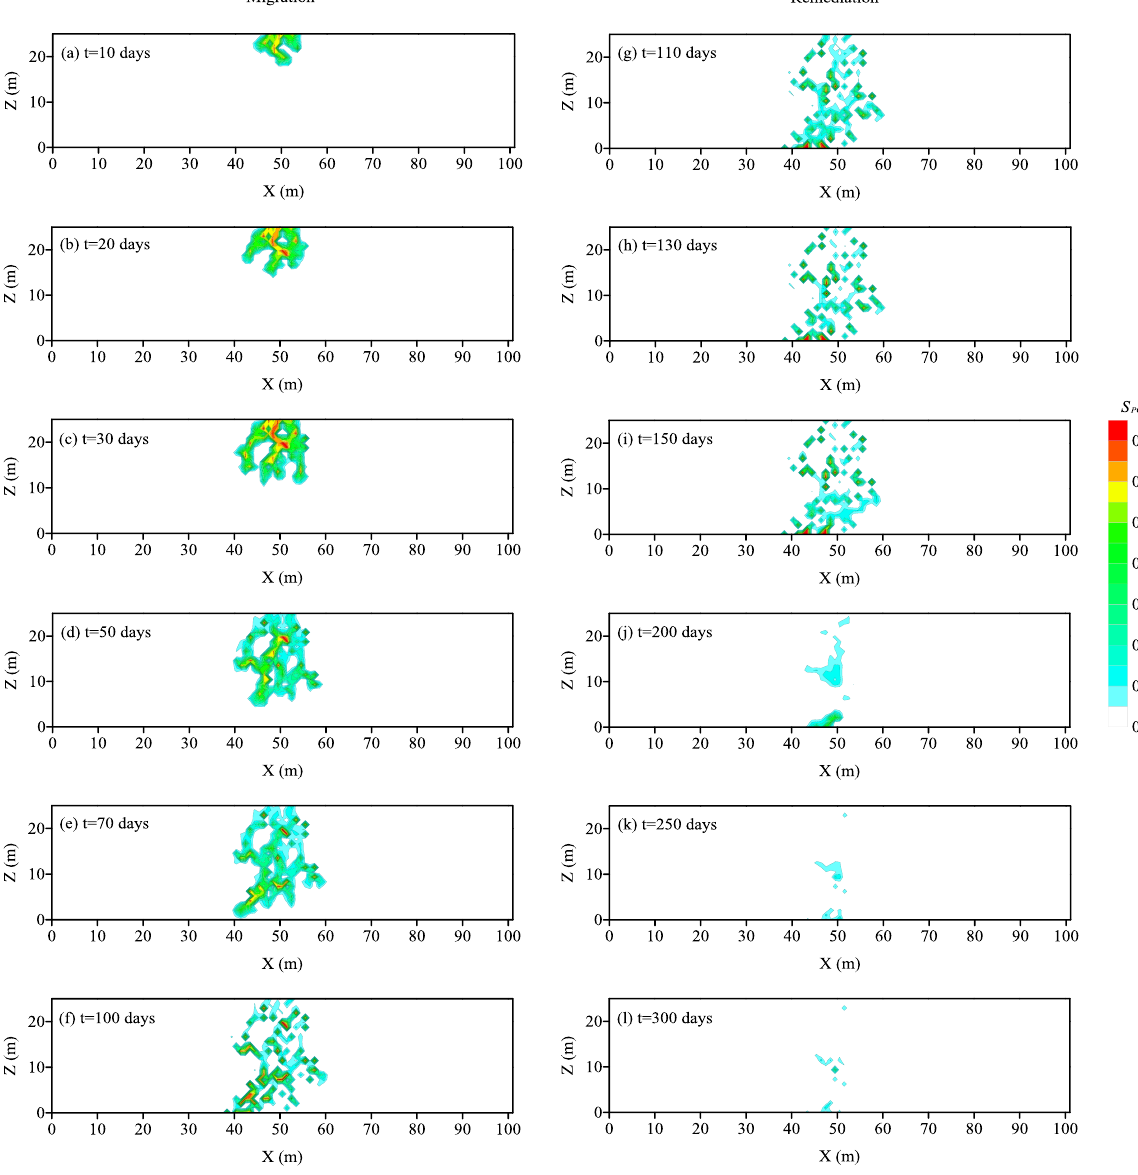
Figure 5. Simulated PCE saturation for individual realization of RTA over the entire migration and remediation periods (0 ∼ 300